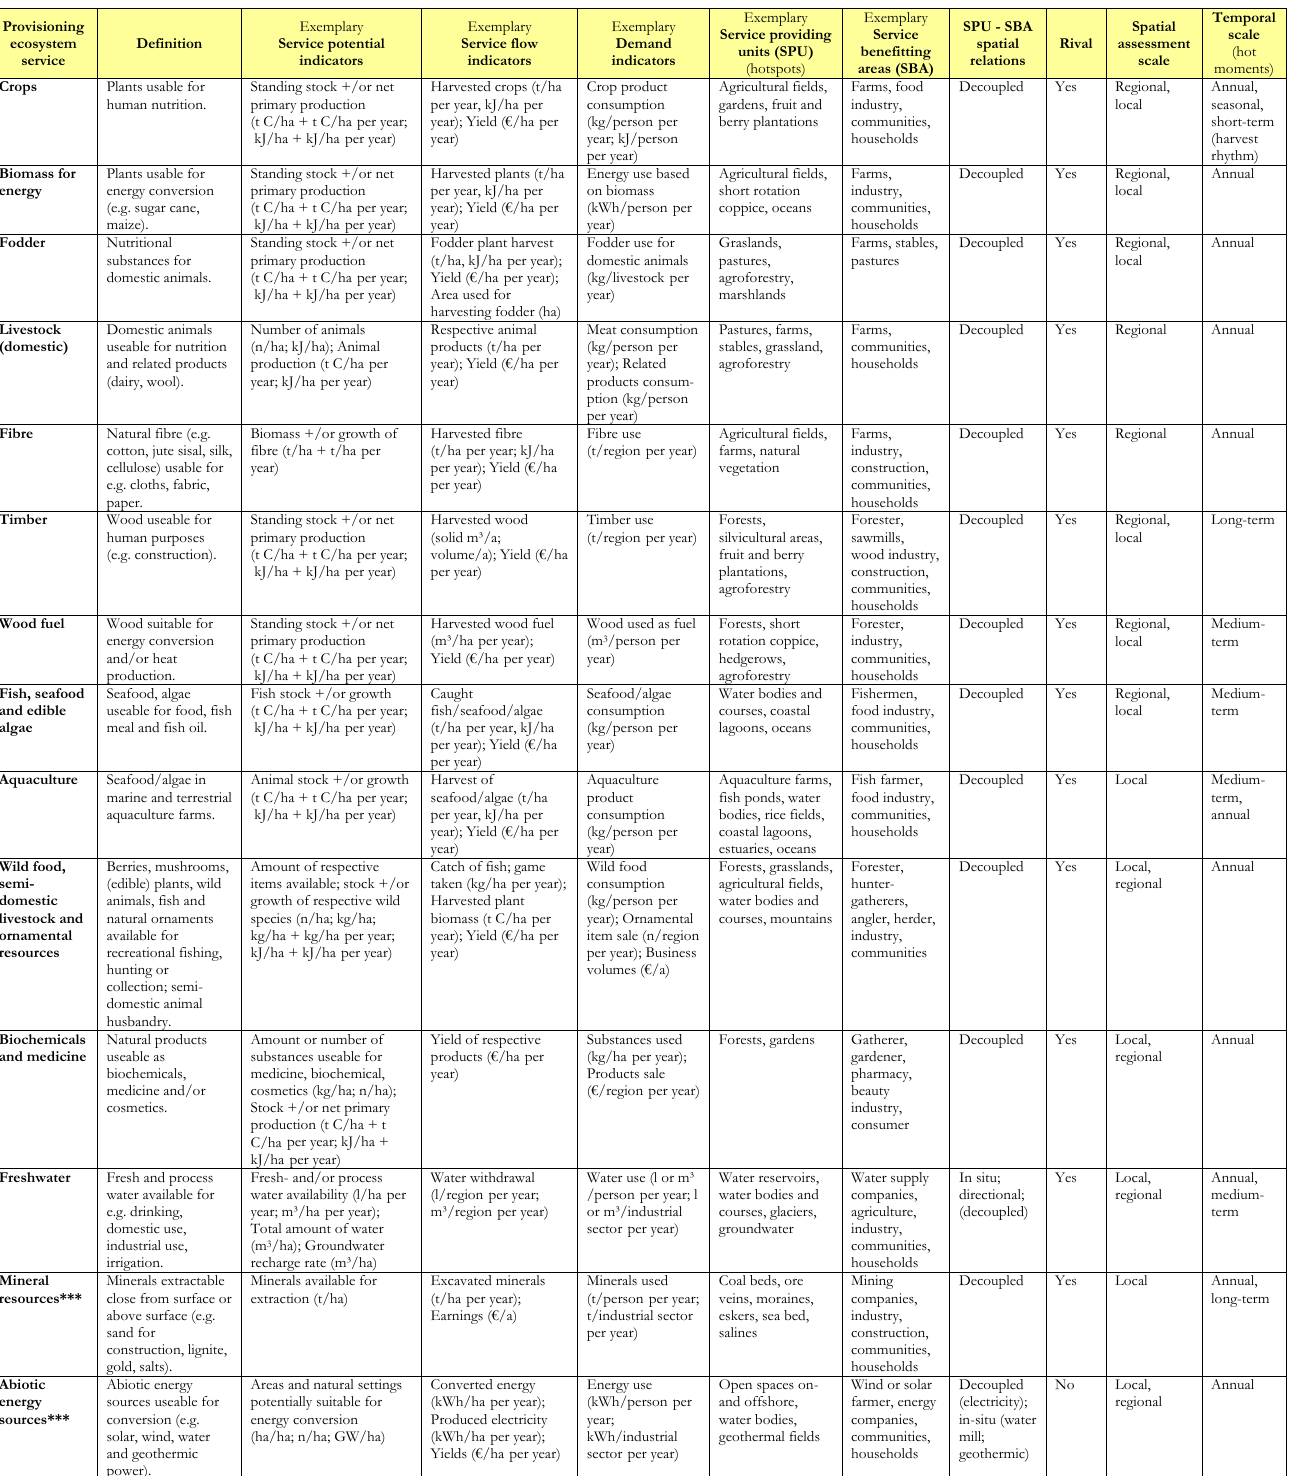
Table 2: Provisioning ecosystem services: definitions, servicepotential (stock) indicators, service flow indicators, demand indicators, exemplary service providing units (hotspots) and service benefitting areas, suggested spatial and temporal assessment scales (based on Kandziora et al. 2013a; Burkhard et al. 2009 and 2012; Schröter et al. 2014; Syrbe and Walz 2012; de Groot et al. 2010).